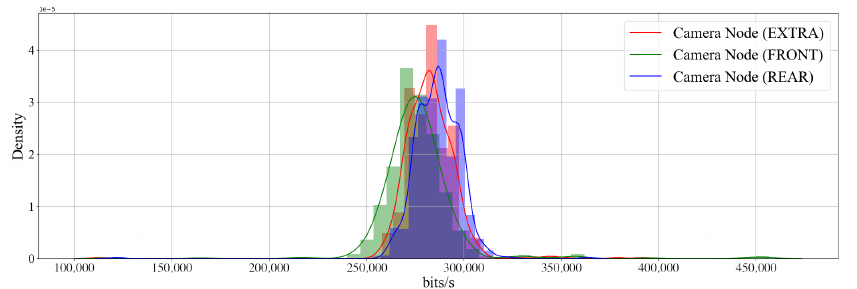
Figure 15. Throughput of three camera nodes in an intra-vehicle environment where readings were taken over 10 min.